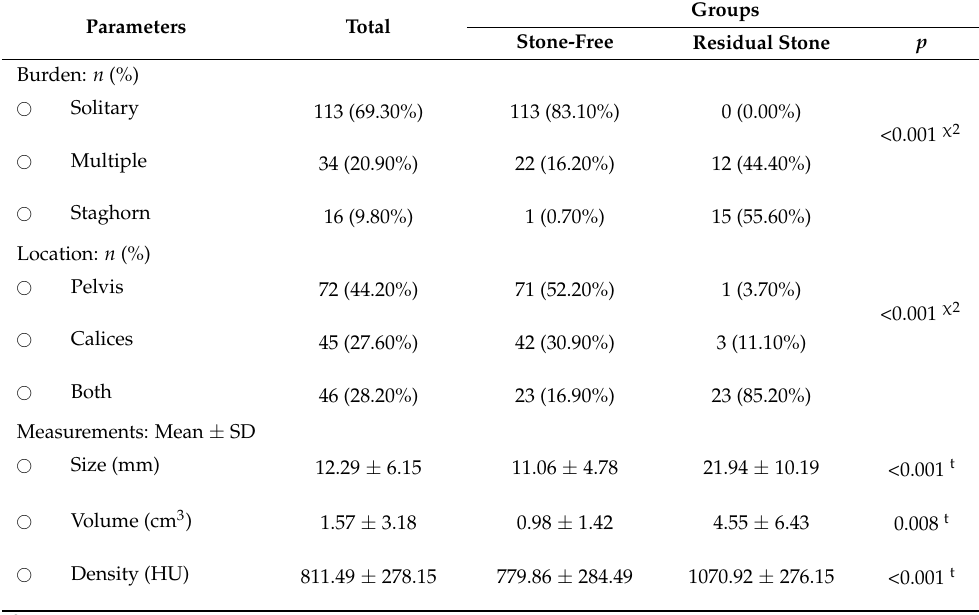
Table 2. Stone characteristics across the stone-free and residual-stone groups. Parameters Total